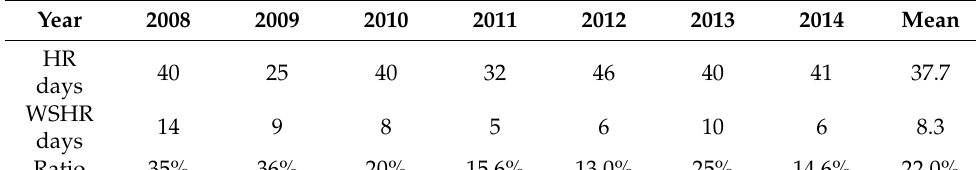
Table 1. The number of HR versus WSHR days, and the ratio of HR days to WSHR days over South China during the pre-summer months of 2008–2014.